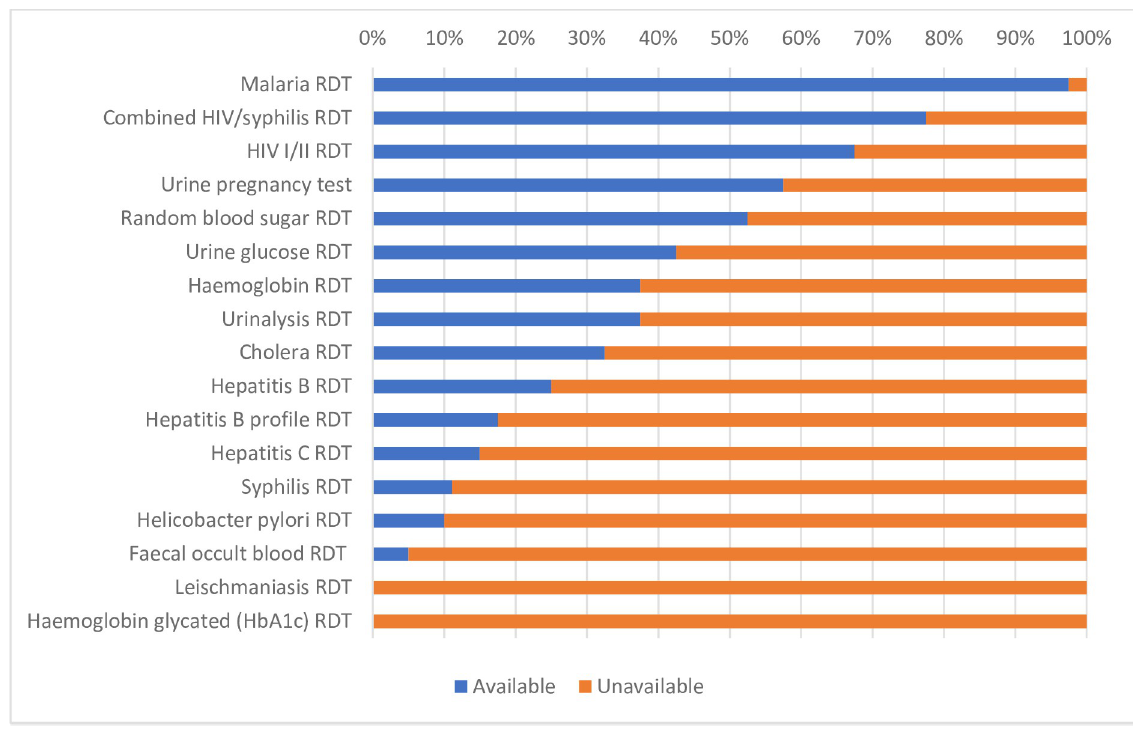
Fig 1. Availability of